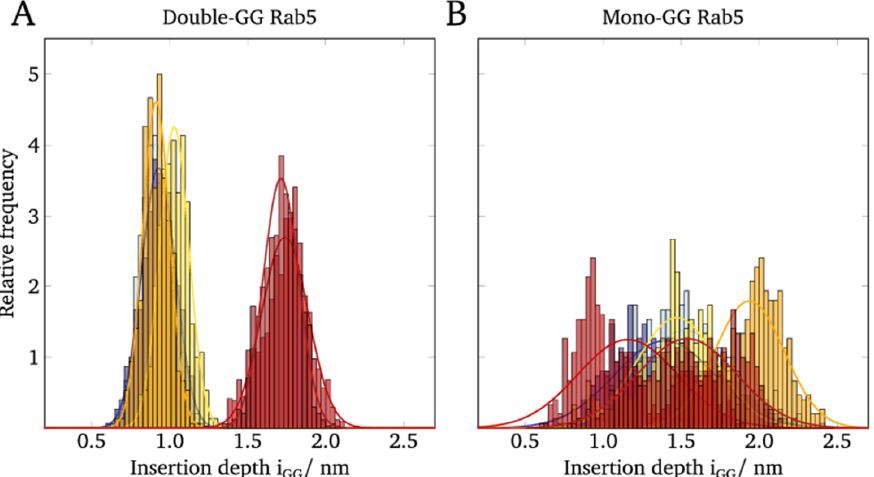
Figure 4. Distribution of the GG anchor insertion depths of ( A ) double-GG Rab5 and ( B ) mono-GG Rab5 in different membranes.